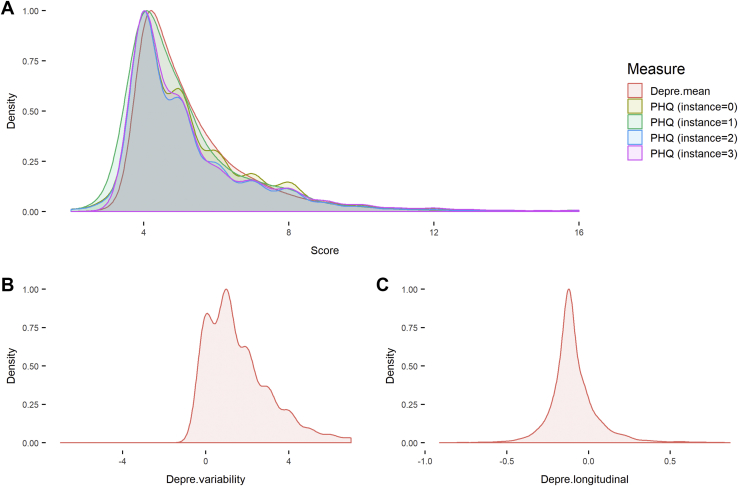
Distributions of Patient Health Questionnaire-4 (PHQ) and derived measures for depressive symptoms. (A) Density plot for all 4 time points of assessment for PHQ. Instance = 2 was for imaging assessment, and the depressive level acquired from this instance was used as a baseline one-time measure for depressive symptoms. The mean depressive level over a minimum of 2 time points of assessment (Depre.mean) is also presented in this panel. (B) Density plot for instability of depressive symptoms (Depre.variability). (C) Density plot for the distribution of slope for the longitudinal trajectory of depressive level over 4 instances (Depre.longitudinal). The density plots were made using the geom_density function in ggplot2 with a smoothness adjustment of 2.